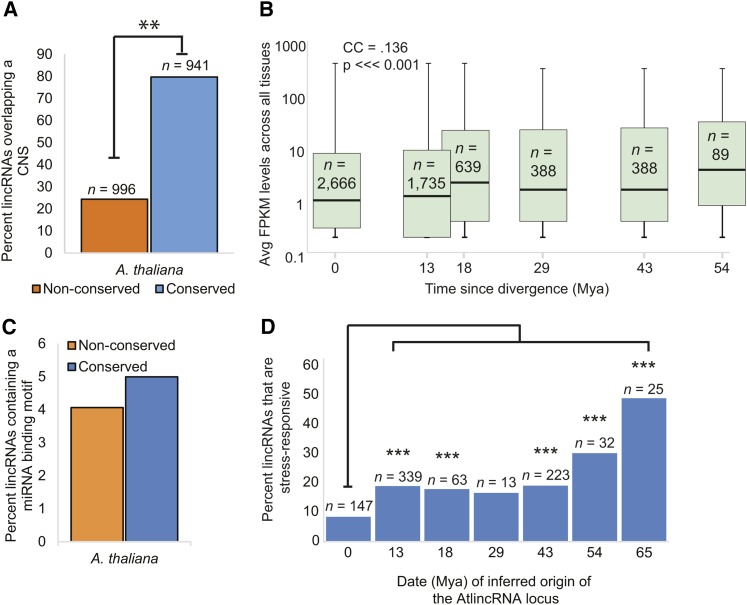
Features enriched in conserved AtlincRNAs. (A) Percent of AtlincRNA loci overlapping with conserved noncoding sequence defined by Haudry et al. (2013). Conserved AtlincRNA loci are defined by having sequence homologs in ≥ four species, with at least one species in the opposite lineage (i.e., Lineage II). Nonconserved AtlincRNAs are those with < four sequence homologs. ** P-value < 0.001. (B) Box and whiskers plot of expression values for AtlincRNA families with homologous loci identified for increasingly divergent species. Expression is denoted as the average FPKM (fragment per kilobase of exon per million fragments mapped) values across four different tissues along a logarithmic scale [flowers, leaves, siliques, root; values from Liu et al. (2012)]. Transcription data were available for 2666 AtlincRNAs. The number of families with representatives at each divergence time-point is listed. Divergence times correspond to those shown in Figure 1A. A Pearson’s Correlation Coefficient was calculated (CC, top left). A linear regression analysis was performed to determine the statistical significance of this coefficient. (C) Percent of all nonconserved (orange) or conserved AtlincRNA (blue) families with miRNA binding motifs. (D) Percent of stress-responsive AtlincRNAs out of total number of AtlincRNAs conserved to each node (nodes indicates by divergence dates shown along x-axis). Actual number of stress-responsive AtlincRNAs shown above each bar. Where shown, *** indicates P-value < 0.0001 relative to the A. thaliana-specific lincRNAs (node 1).